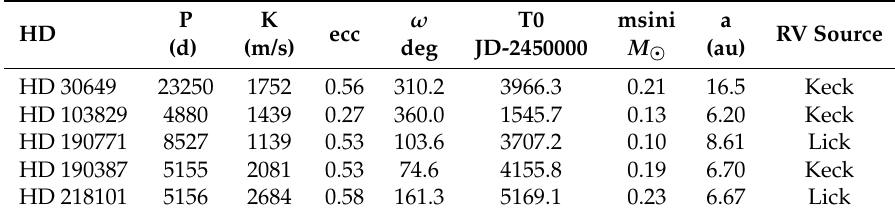
Table 1. Preliminary spectroscopic orbital solutions from the individual radial velocity time series published by [42] for Lick and by [41] for Keck